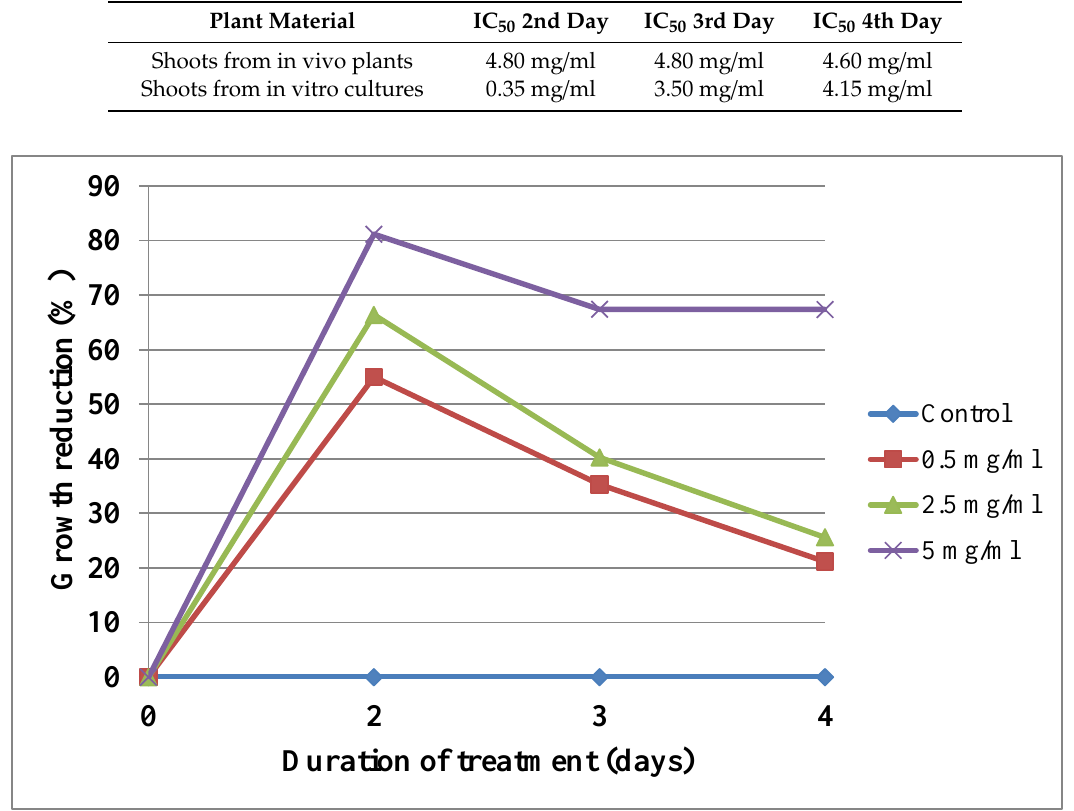
Figure 5. The effect of the extract from in vitro shoot cultures of Eryngium alpinum L. [0.5 mg/mL, 2.5 Figure 5. The e ff ect of the extract from in vitro shoot cultures of Eryngium alpinum L. [0.5 mg / mL, 2.5 mg/mL, 5 mg/mL] on inhibition of Acanthamoeba trophozoites proliferation in the culture medium. mg / mL, 5 mg / mL] on inhibition of Acanthamoeba trophozoites proliferation in the culture